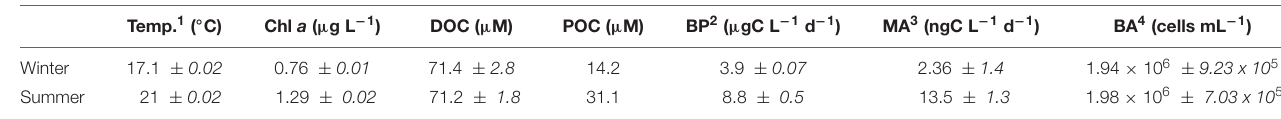
TABLE 1 | In situ conditions off Scripps Pier at the time of sampling (mean ± standard deviation for n = 3). Temp. 1 ( ◦